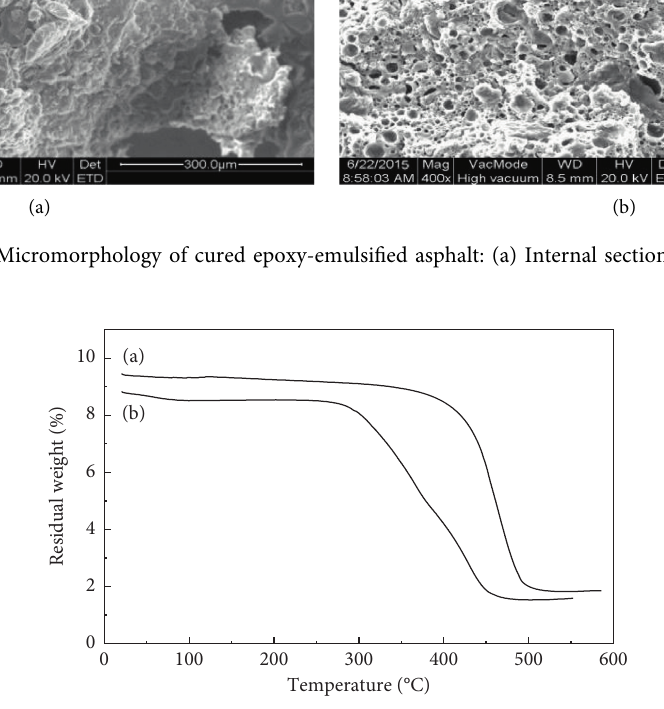
Figure 23: Thermogravimetric analysis curve of cured product: (a) commonly used asphalt-cured product for fog seal layer; (b) epoxy emulsified asphalt-cured product.